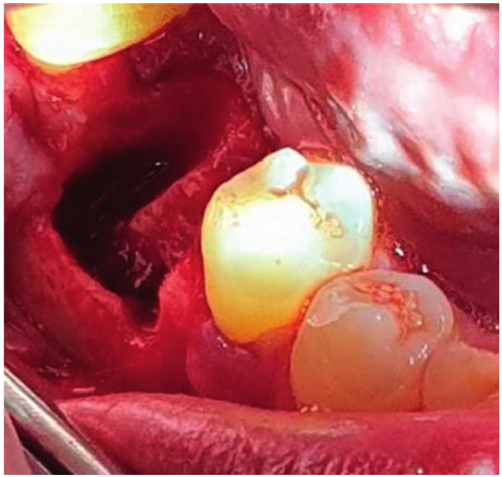
Figure 2: Atraumatic extraction and full-thickness flap were